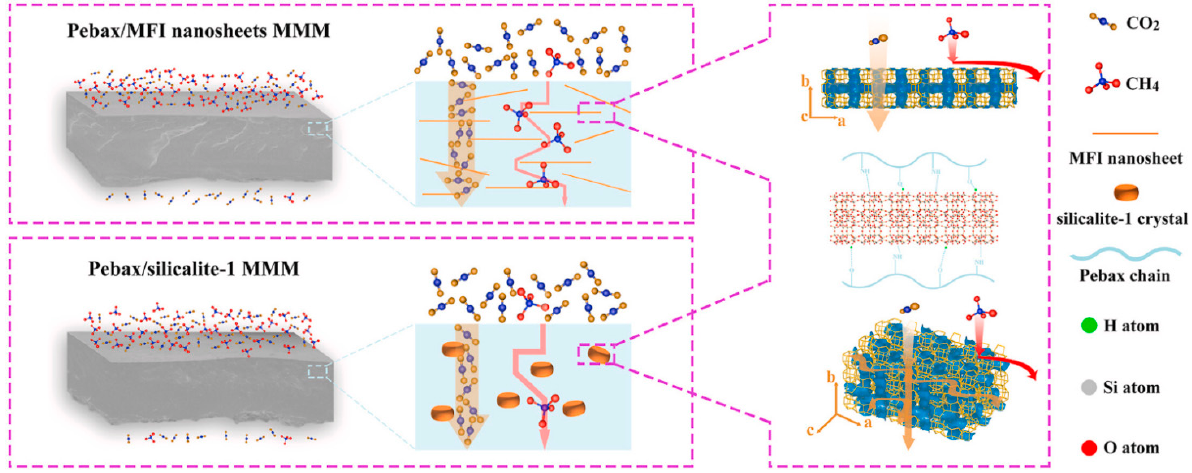
Figure 7. Scheme of MMMs loaded with zeolite as nanosheets or as nanoparticles (from ref. [62]). The 2D-geometry of the nanosheets allows the synergistic action of multiple fillers in combination with respect to a single non-2D filler